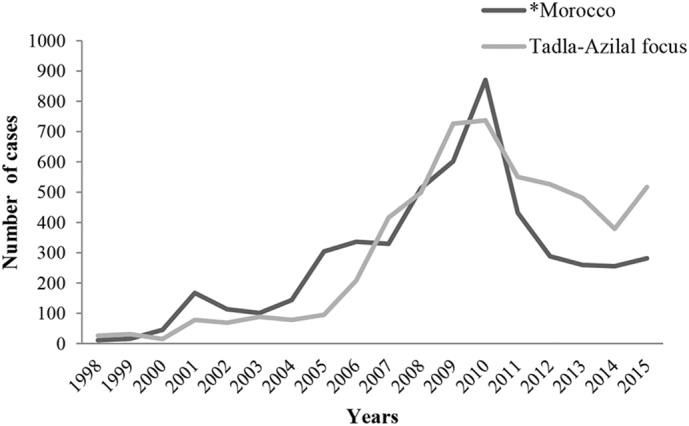
Cutaneous leishmaniasis in Morocco and in Tadla-Azilal focus between 1998 and 2015.(Data source: Moroccan Ministry of Heath, 2016).⁎Number of cases multiplied by 10−1.